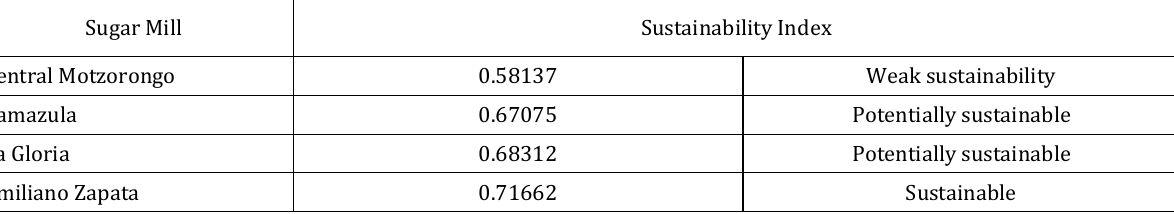
Table 8. Sustainability index for all case studies (1=high, 0=null).